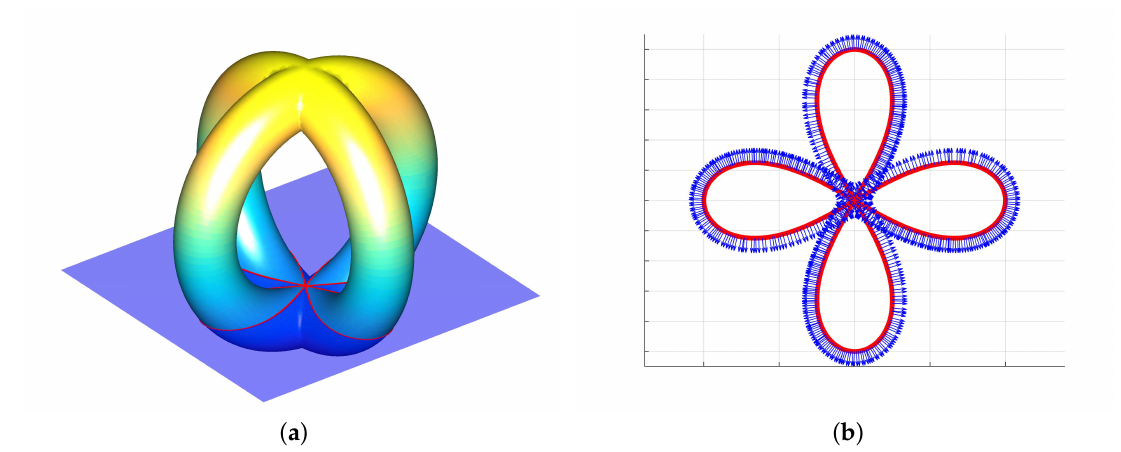
Figure 5. Double Torus dataset. Computation of non-Morse 1D level set S O . ( a ) Double Torus dataset; ( b ) Oriented contour with degenerate saddle point.